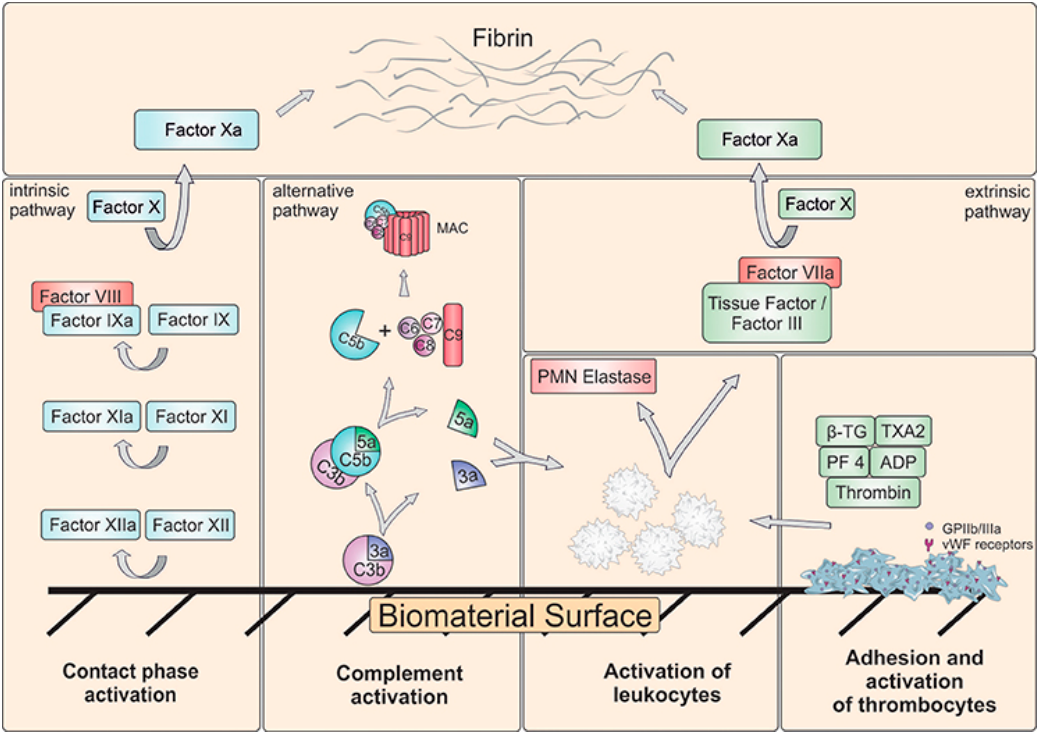
Figure 2. Schematic representation of the main biological processes that can occur at the blood-biomaterial surface. Reproduced with permission from [54].